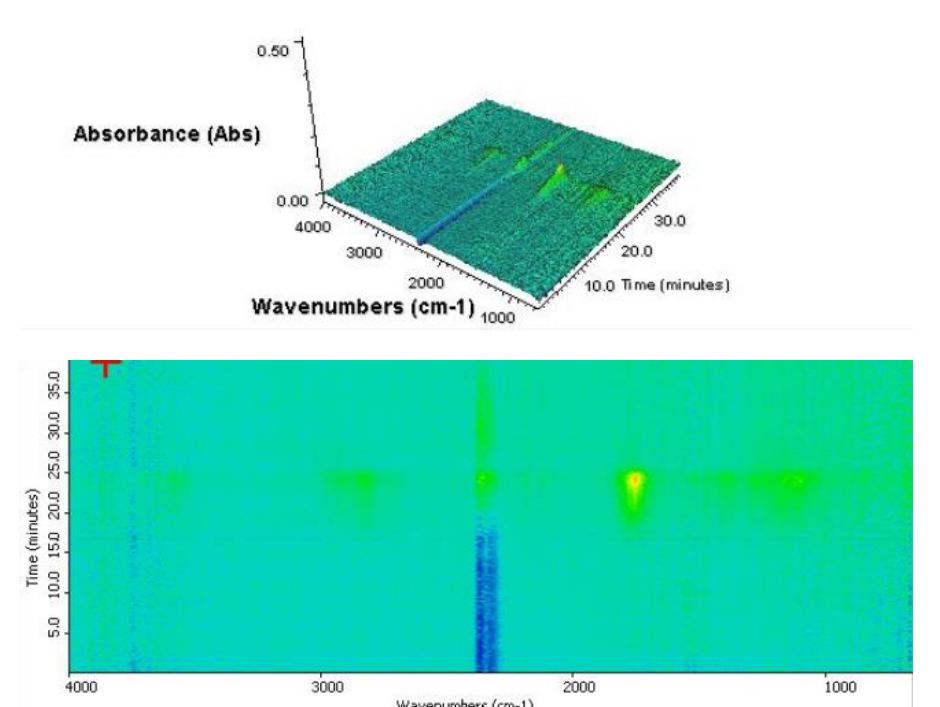
Figure 5. FTIR analysis of the purified wooden tie sample.